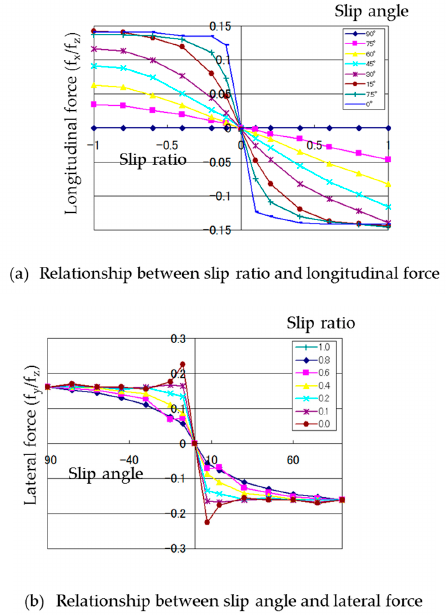
Figure 8. Slip characteristics of barrel-type magnetic wheel. ( a ) Relationship between slip ratio and longitudinal force where slip angle is changed from 0 degree to 90 degrees. ( b ) Relationship between slip ratio and lateral force where slip ratio is changed from 0 to 1.